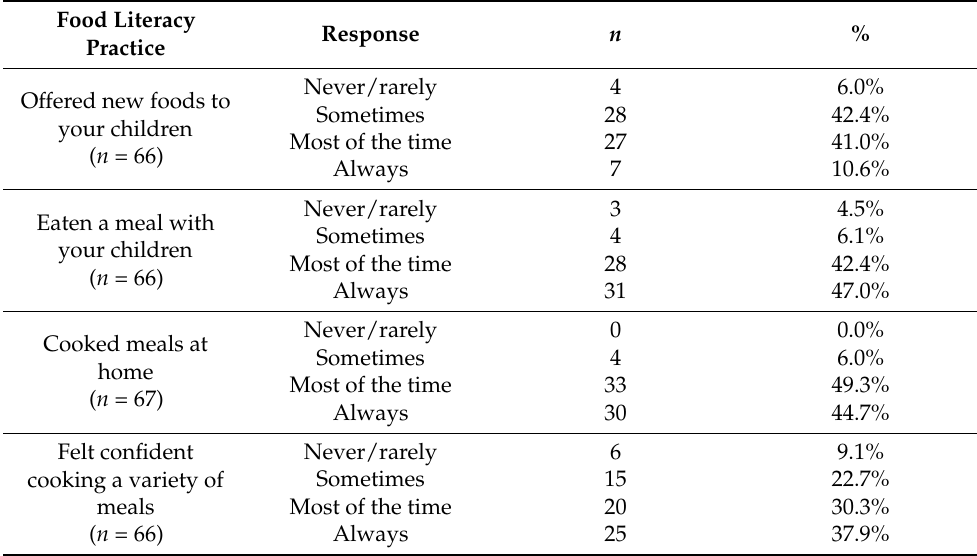
Table 2. Frequency of food literacy practices of focus group